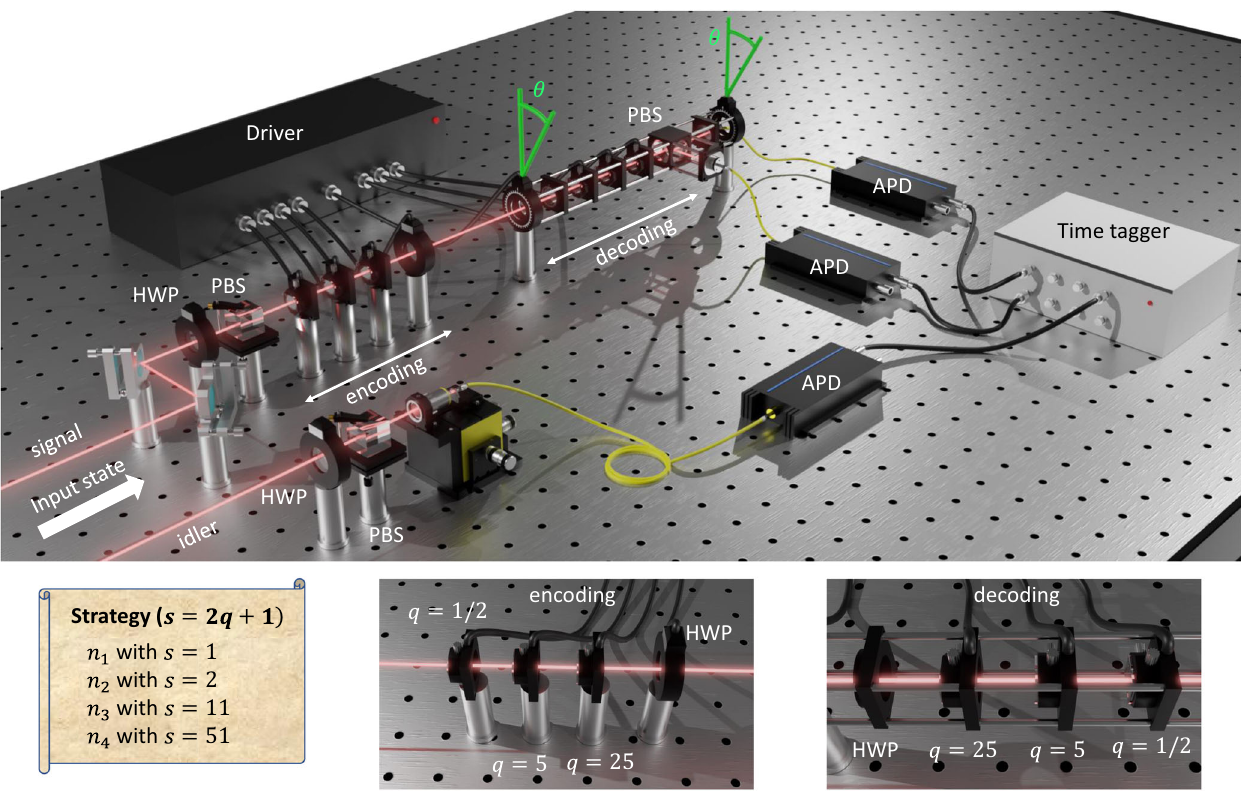
Fig. 2 Experimental setup. Single photon pairs are generated by a degenerate type-II SPDC process inside a ppKTP pumped by a 404 nm cw laser. The idler photon is measured by a single photon avalanche photodiode (APD) and acts as a trigger for the signal that enters the apparatus. This consists of an encoding stage which is composed of a fi rst polarizing beam splitter (PBS) and three q-plates with different topological charges q = 1/2, 5, 25, respectively, followed by a motorized half-waveplate (HWP). The decoding stage is composed of the same elements of the preparation mounted, in the reverse order, in a compact and motorized cage that can be freely rotated around the light propagation axis of an angle θ . After the fi nal PBS, the photons are measured through a set of two APDs. Coincidences with the trigger photon are measured, analyzed via a time-tagger, and sent to a computing unit. The latter, according to the pre-calculated optimal strategy, controls all the voltages applied to the q-plates and the angle of rotation of the measurement